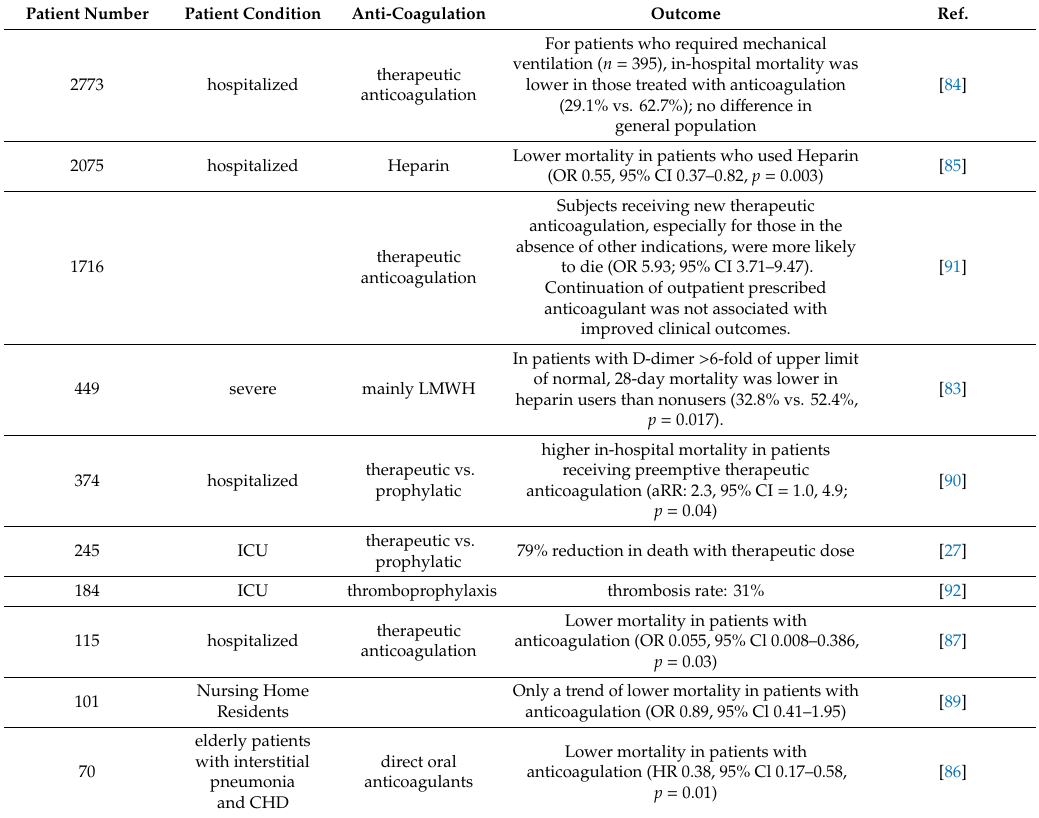
Table 1. Use of anticoagulants and outcomes in COVID-19 patients. CHD: chronic heart disease; aRR: adjust risk ratio; HR: Hazard ratio; OR: odd ration; LMWH: Low molecule weight